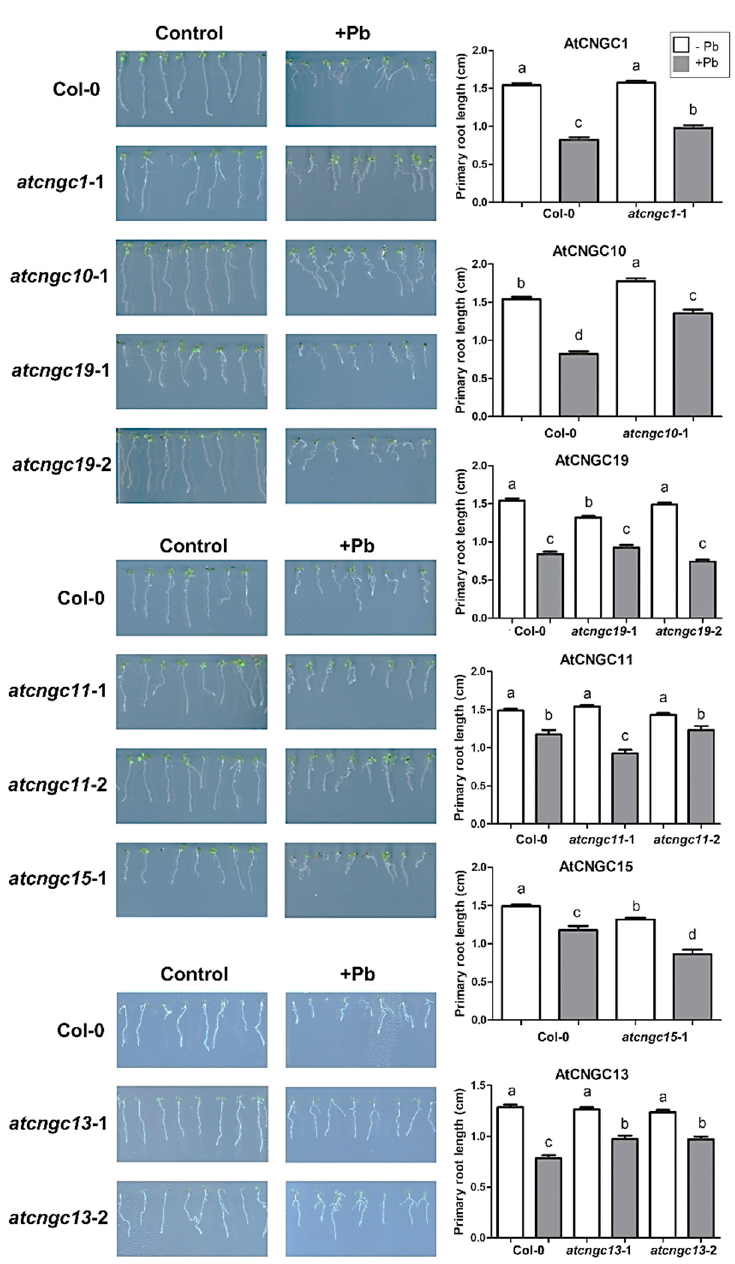
Figure 2. Growth of the Arabidopsis wild-type and atcngc mutants in response to Pb 2+ . Eight-day-old seedlings grown on agar media containing 150 μ M Pb(NO 3 ) 2 were photographed and were used to measure primary root growth (length) using ImageJ software. The presented images (left side of figure) are representative of ≥ 80 seedlings of each genotype (the mutant or the wild-type) used to measure the primary root length for each treatment (right side of figure). Quantitative data presented represents the mean ± SEM. Data were subjected to a one-way ANOVA with a post-hoc Tukey’s comparison. Different letters indicate significant differences (p < 0.05).